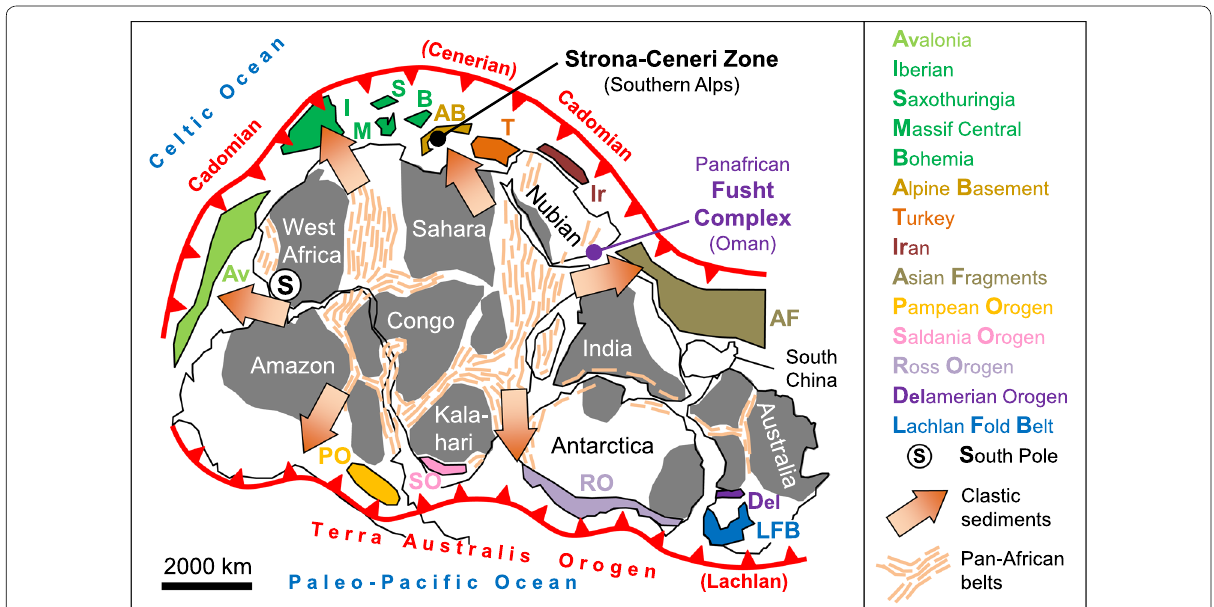
Fig. 15 Map of Gondwana in the period of 550–500 Ma with indicated Paleozoic orogenic sutures, along which material (mainly detritus) was accreted and recycled by the cratonization of subduction–accretion complexes (see Table 4). The Cenerian (490–440 Ma) and Lachlan (430–370 Ma) orogenies occurred later and are therefore in brackets. The Strona-Ceneri Zone is part of the Alpine Basement (AB). The Fusht Complex in southern Oman (790 Ma) belongs to an older Pan-African arc system (drawn after Kröner and Stern 2004; Schmitt et al. 2004; Linnemann 2007; Fernández et al. 2008; Foster and Gray 2008; Schwartz et al. 2008; Ustaömer et al. 2009; Torsvik and Cocks 2011; Koralay et al. 2012; Foster and Goscombe 2013; Lin et al. 2013; Hu et al. 2015; Santosh et al. 2014; Rossetti et al. 2015; Shafaii Moghadam et al. 2015; Villaseca et al. 2016; Avigad et al. 2017; Li et al. 2017; and Zurbriggen 2017. Pre-Variscan basements of the Alps, including the Strona-Ceneri Zone (SCZ), were located according to Von Raumer et al.